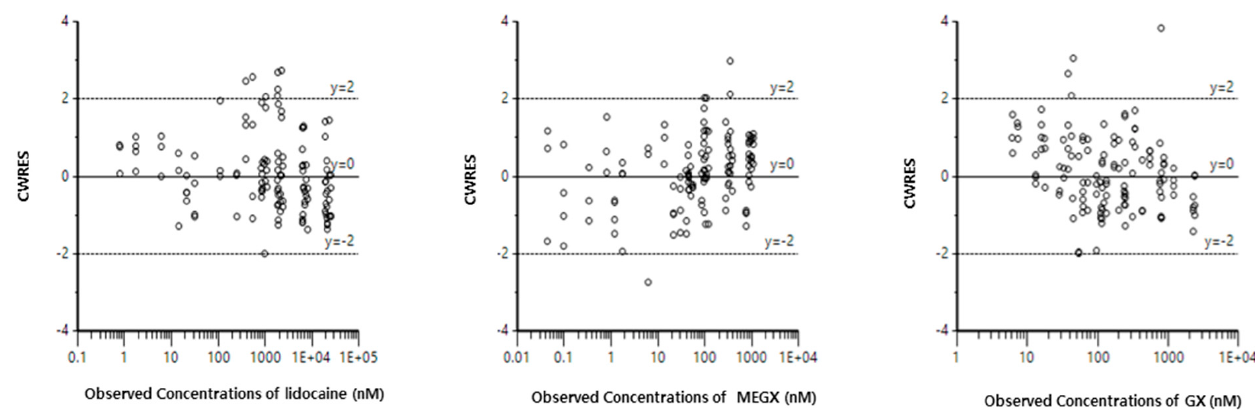
Figure 5. Goodness-of-fit plots for the final model. Individual predicted concentrations of lidocaine, MEGX, and GX vs. observations (upper) and conditional weighted residuals (CWRES) vs. observations (lower). Circles represent the observed lidocaine, MEGX, and GX concentrations.